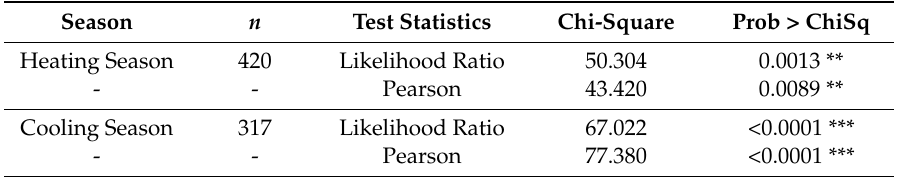
Table 9. Contingency analysis of user satisfaction on air temperature by size of zone by